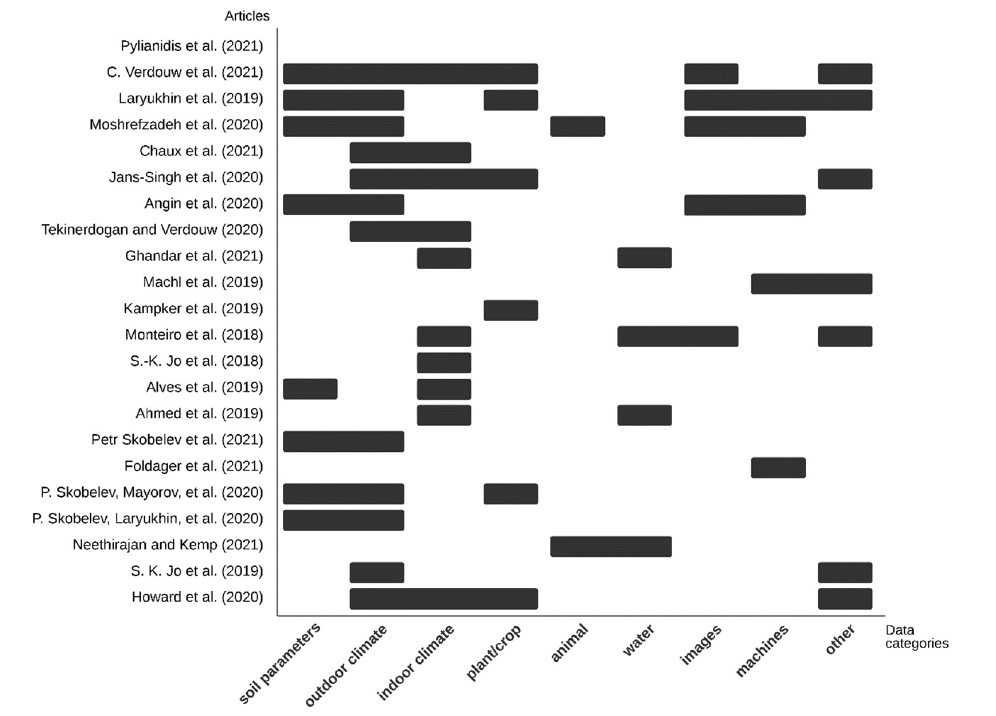
Figure 3. Data types per article [3,4,8,9,28-45].